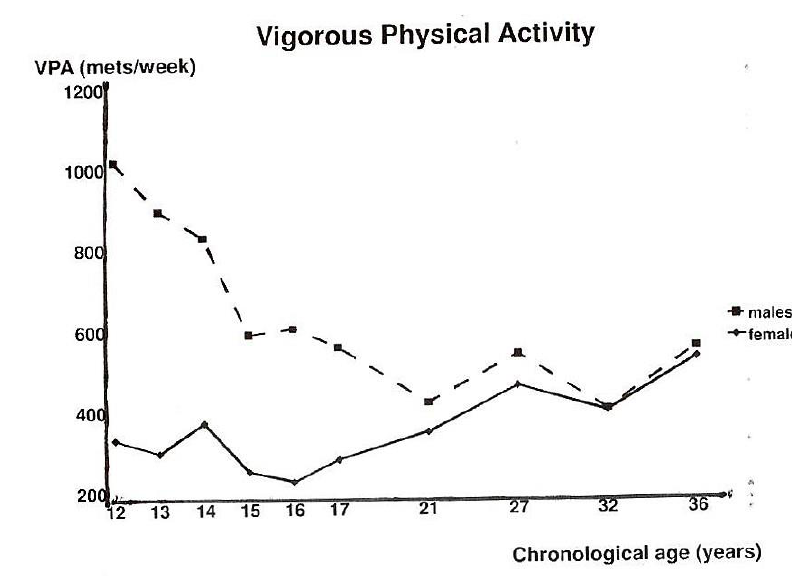
Figure 8. Mean values of vigorous physical activity levels (VPA) in METs/week, separately for males and females [14].